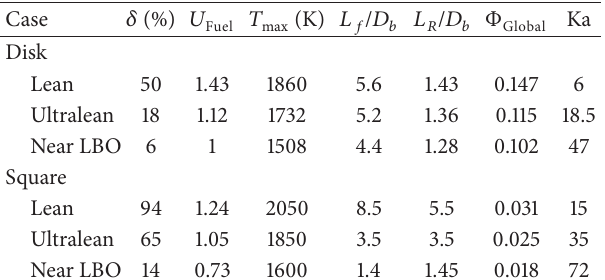
Table 1: Operating conditions and